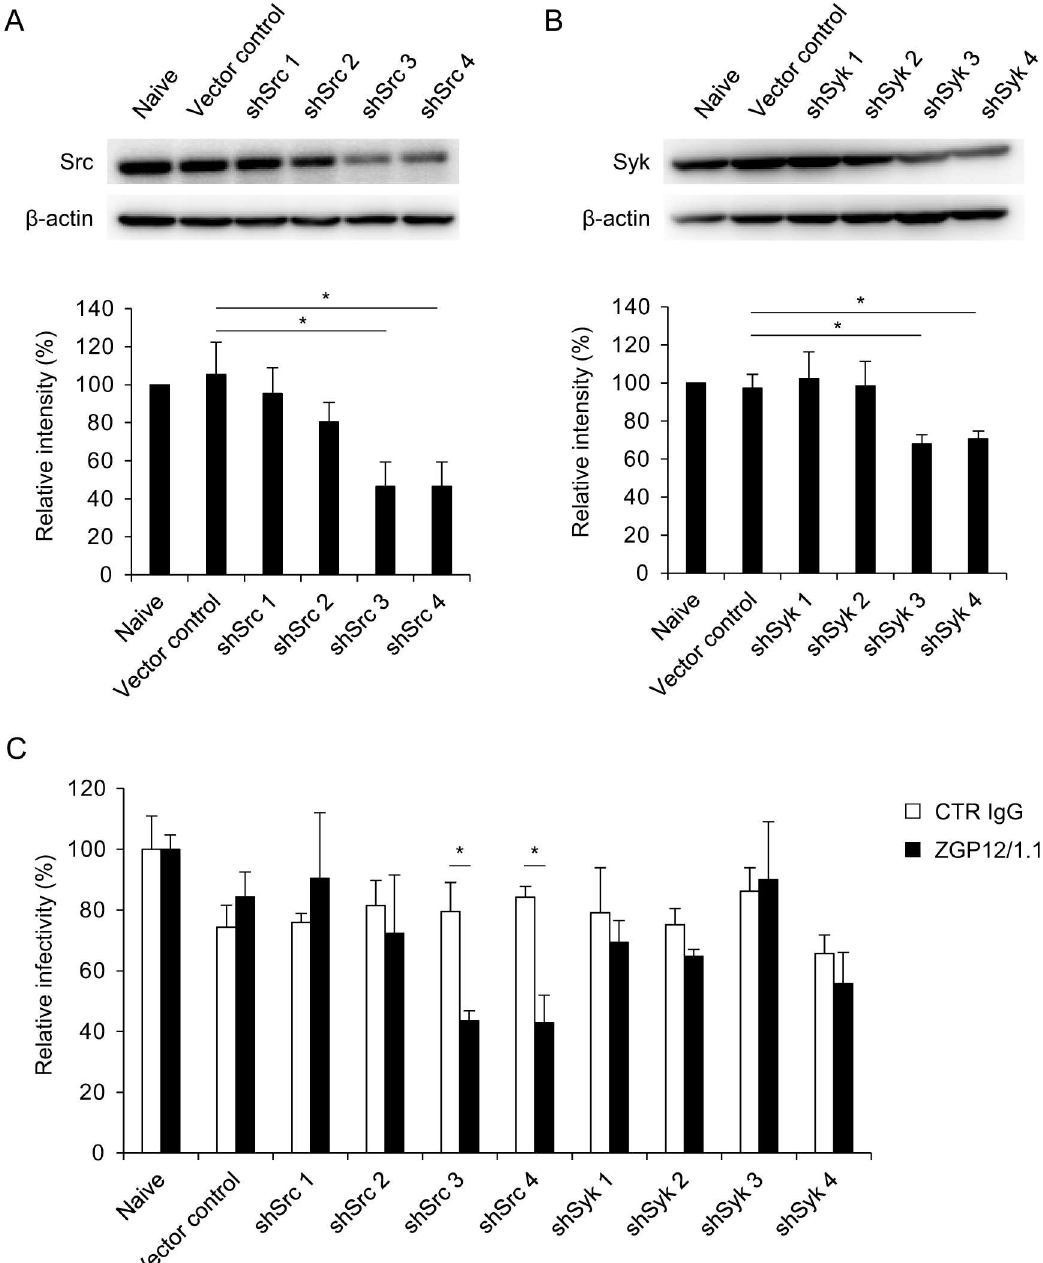
Fig 4. Effects of Src and Syk knockdown on EBOV ADE. (A, B) Validationof knockdown efficiency of Src and Syk in K562 cell lines. (C) Relativeinfectivity of VSV-EBOV GP in K562 cell lines. Src (A) and Syk (B) proteins in each cell line were detected by Western blotting. The band intensity of Src and Syk was standardized with that of the β -actinband for each cell line. Relativeintensitiesof the Src and Syk bands were then calculatedby setting the intensity of naive K562 cells to 100%. These cell lines were infected with VSV-EBOV GP preincubatedwith CTR IgG or ZGP12/1.1 (C). The relative percentage of infectivity was calculatedby setting the IU value of the viruses in na ï veK562 cells to 100%. The mean and standarddeviationof three independentexperiments are shown. Statistical analysiswas performed using Student’s t -test ( * p < 0.05).